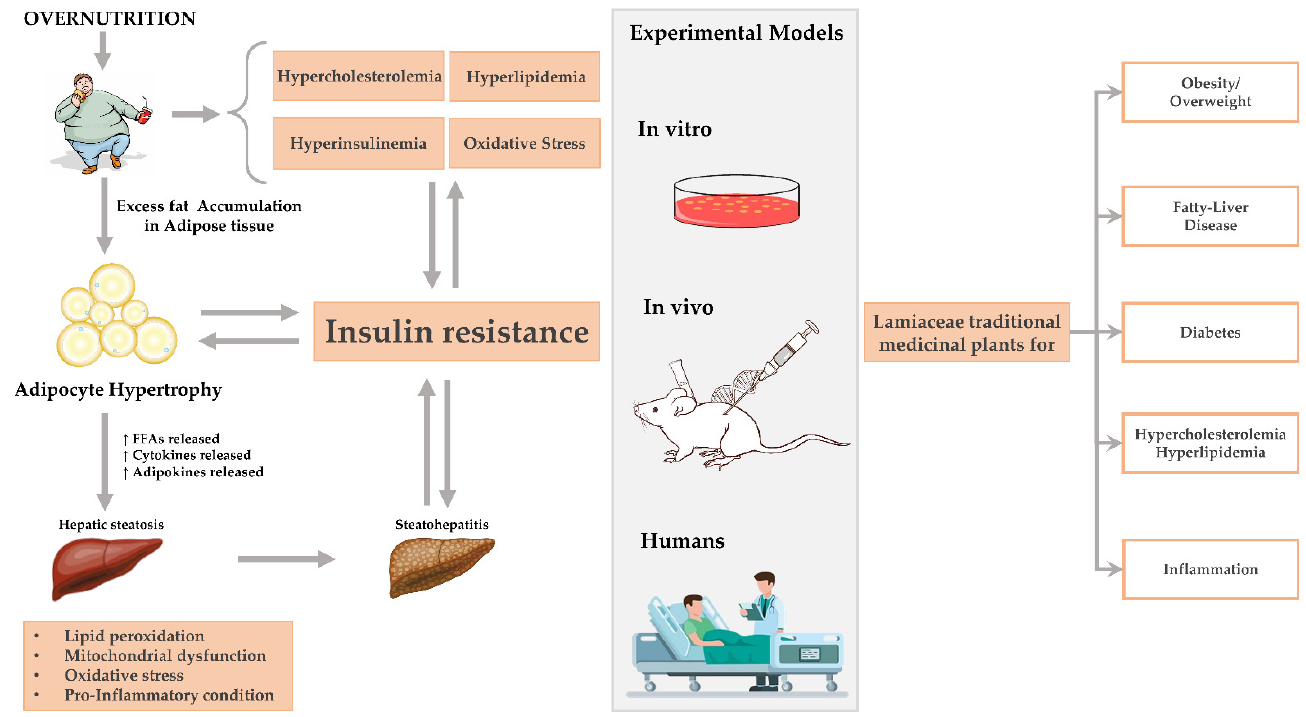
Figure 4. A schematic cartoon showing the main complications resulting from overnutrition and obesity: primarily liver steatosis and the mechanistic road for its progression, displaying also the potency of Lamiaceae plants in treating these complications in several experimental models (in vitro, in vivo, and clinical trials).